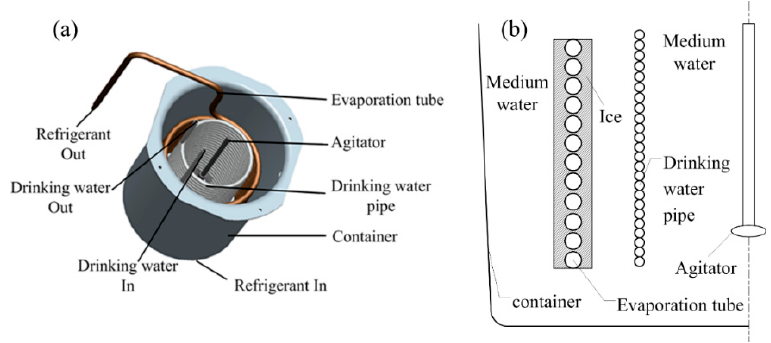
Figure 1. Schematic of the ice storage system: ( a ) graphic model of the device; and ( b ) simplified cross section.